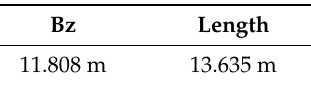
Table 5. Z component and length when the connecting rod forms an angle of 59.9949 ◦ with the horizontal plane.